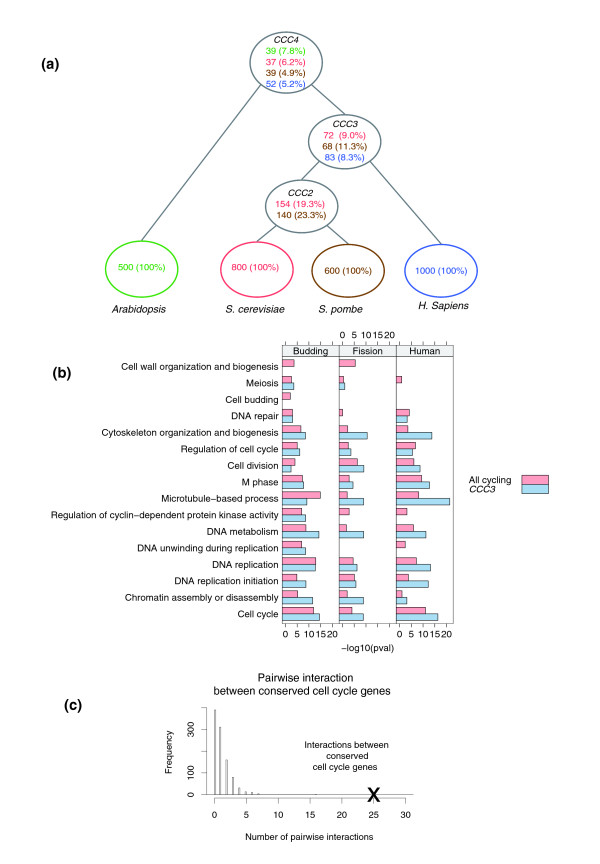
Conservation of cycling genes. (a) Percentage of conserved cycling genes in the four species. (b) Enrichment of cell cycle related Gene Ontology GO terms between all cycling genes and the CCC3 set in budding yeast, fission yeast, and humans. (c) Yeast protein-protein interactions [18]. We counted the number of interactions within a random set of 80 cycling yeast genes. In all, 1,000 sets were sampled. The histogram on the left plots the number of interactions observed for these sets. X represents internal interactions with the CCC3 set, which has significantly more internal interactions.